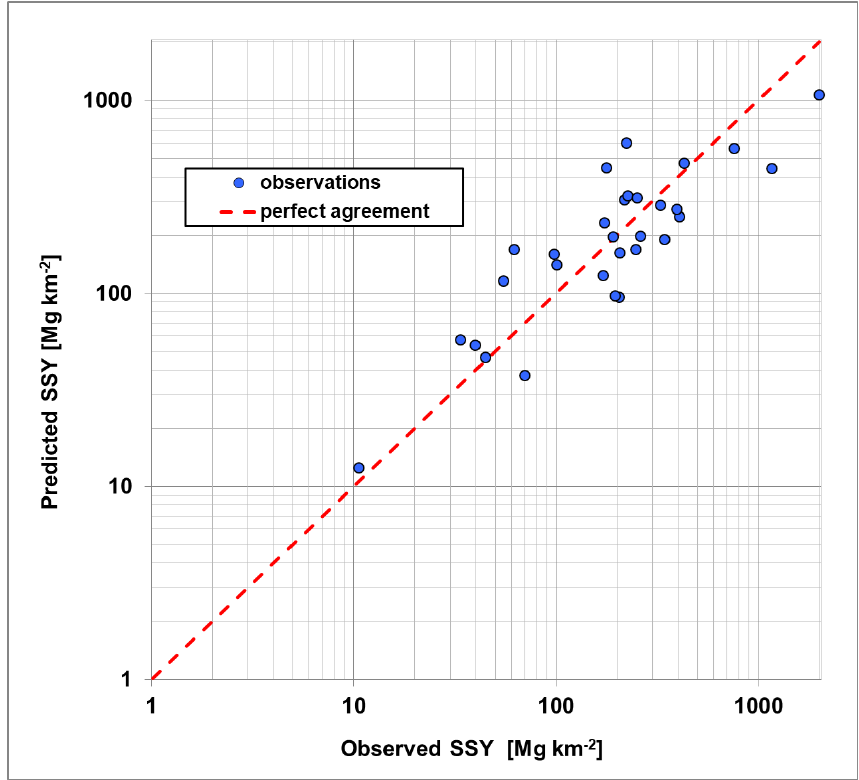
Figure 5. Observed SSY data vs predicted values from model Equation (2).